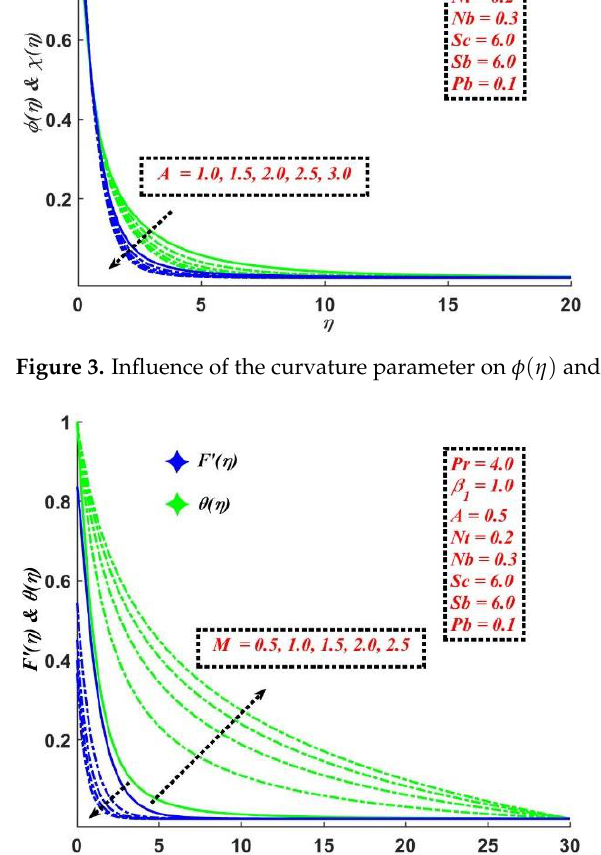
Figure 4. Influence of the magnetic parameter on 𝐹 ′ (𝜂) and 𝜃(𝜂) .